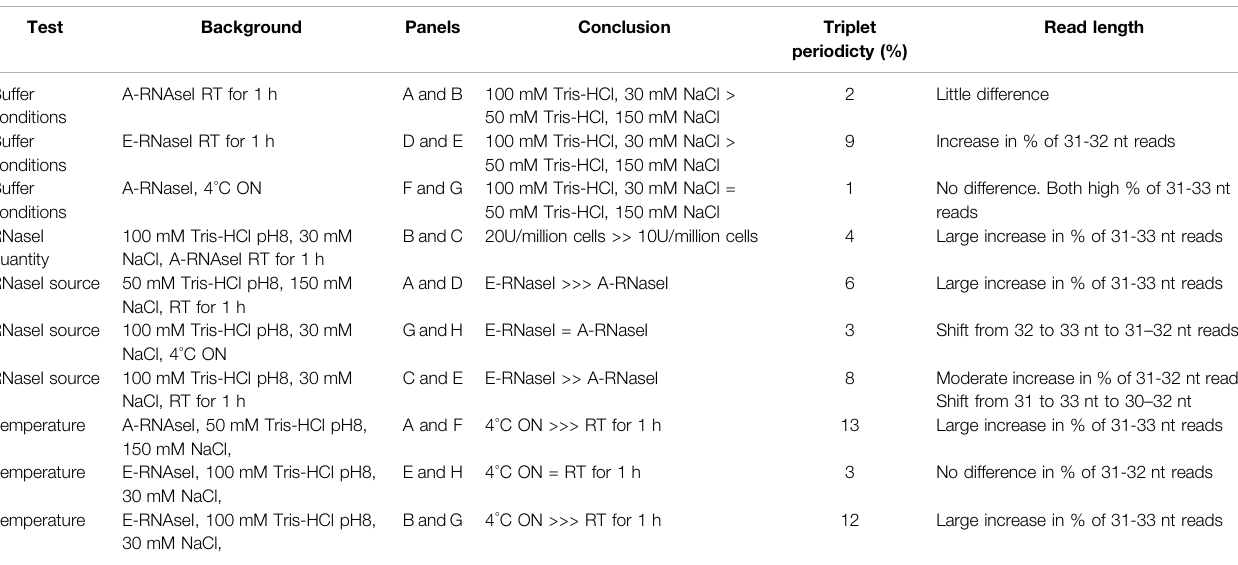
TABLE 2 | Summary conclusions from conditions tested.